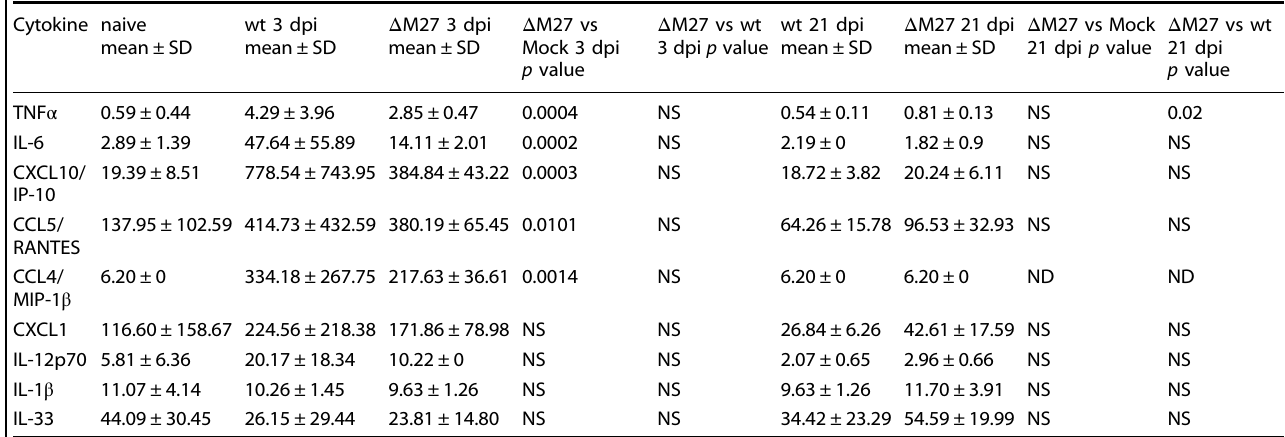
Table 1. Δ M27-MCMV stimulates cytokine responses. Cytokine naive mean ±